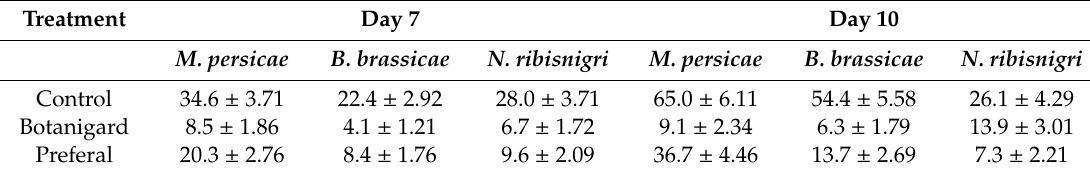
Table 6. Results of a laboratory bioassay of EPF biopesticides against aphid nymphs of M. persicae , B. brassicae and N. ribisnigri . Groups of 15 nymphs were treated with biopesticides and then left to develop into adults and reproduce. Data represent the mean total number of aphids per plant counted at 7 and 10 days after EPF biopesticide application ( ± standard error of the